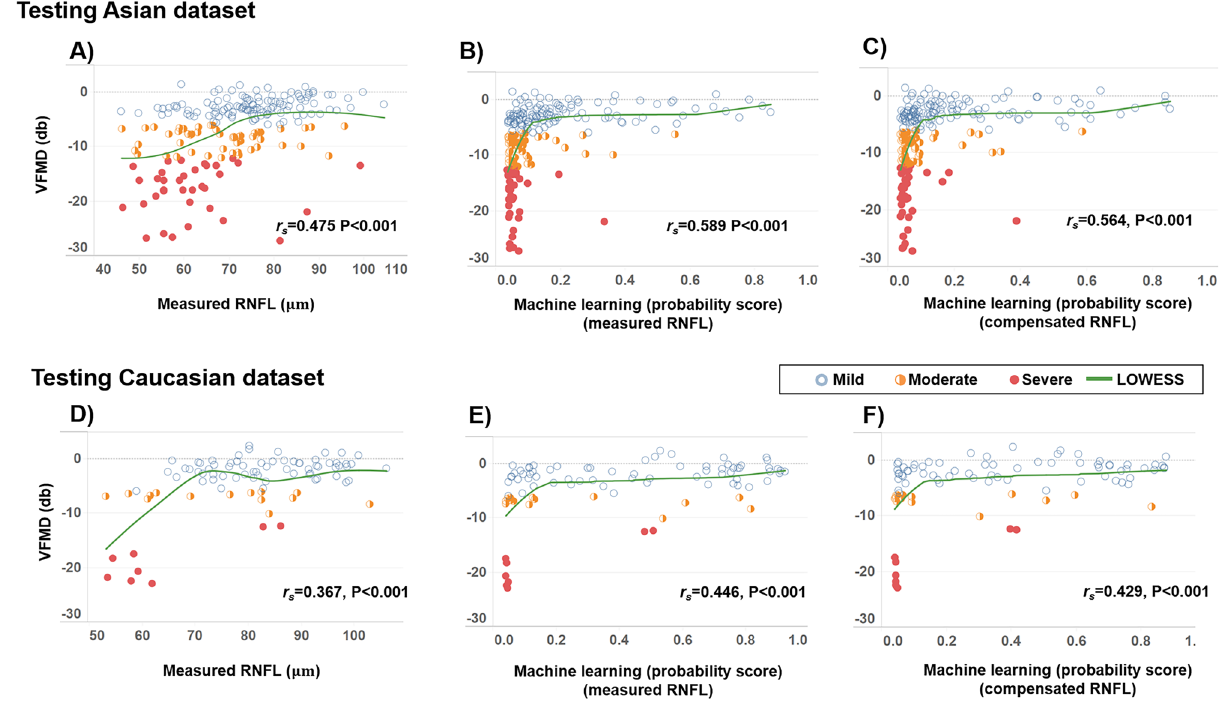
Figure 2. Scatter plots showing the associations between the visual field mean deviation (VFMD) and measured retinal nerve fiber layer (RNFL) thickness for ( A ) Asian and ( D ) Caucasian test datasets. ( B ) and ( E ) show the associations between VFMD, and the probability score generated by a machine learning (ML) model using measured RNFL thickness, where a lower score indicates greater severity of glaucoma. ( C ) and ( F ) show the associations between VFMD, and the probability score generated by a ML model using compensated RNFL thickness, where a higher score indicates greater severity of glaucoma. Spearman’s correlation coefficient ρ and LOWESS curves are indicated for the corresponding variables in each